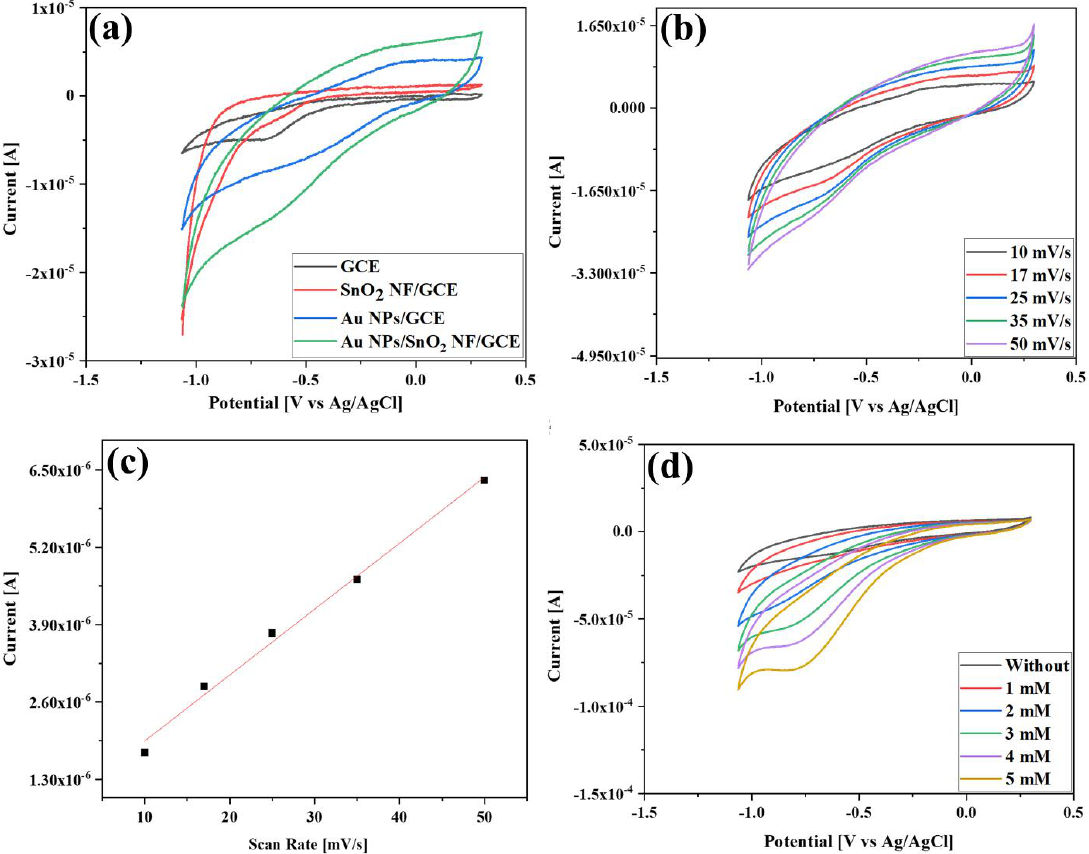
Figure 4. ( a ) CV study of GCE, SnO 2 NFs, Au NPs, and Au NPs/SnO 2 NFs composite electrode in 0.1 M PBS (pH = 7.0) in the absence of H 2 O 2 at a 17 mV/s scan rate; ( b ) CV study of Au NPs–SnO 2 NFs composite electrode without H 2 O 2 in 0.1 M PBS (pH = 7.0) at various scan rates; ( c ) corresponding linear plots of the cathodic peak current versus the scan rate; ( d ) CV study of Au NPs–SnO 2 NFs composite electrode in the presence of varied H 2 O 2 concentrations in a 0.1 M PBS (pH = 7.0) solution at 17